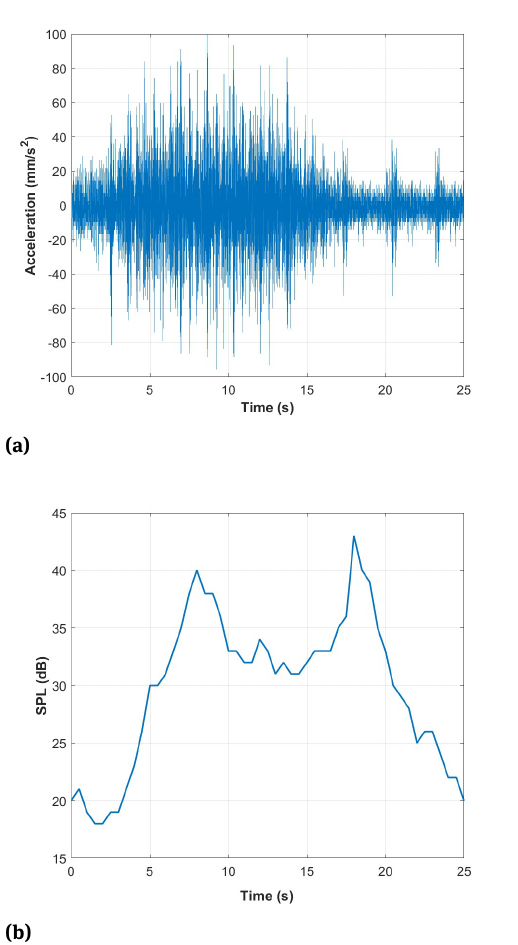
Figure 7: Measured results in time domain at site: (a) vibration ac- celeration in time domain and (b) SPL in time